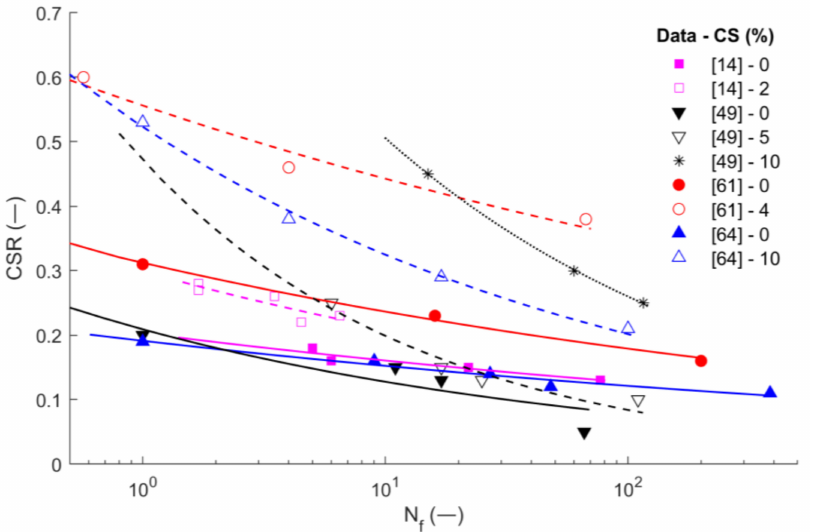
Figure 8. Cyclic Stress Ratio (CSR) against the number of cycles at failure (N f ) after cyclic tests on loose (D r ≤ 45%) untreated and treated sands (data collected from references in the legend; liquefaction resistance curves calculated via a power relation CSR = aN fb